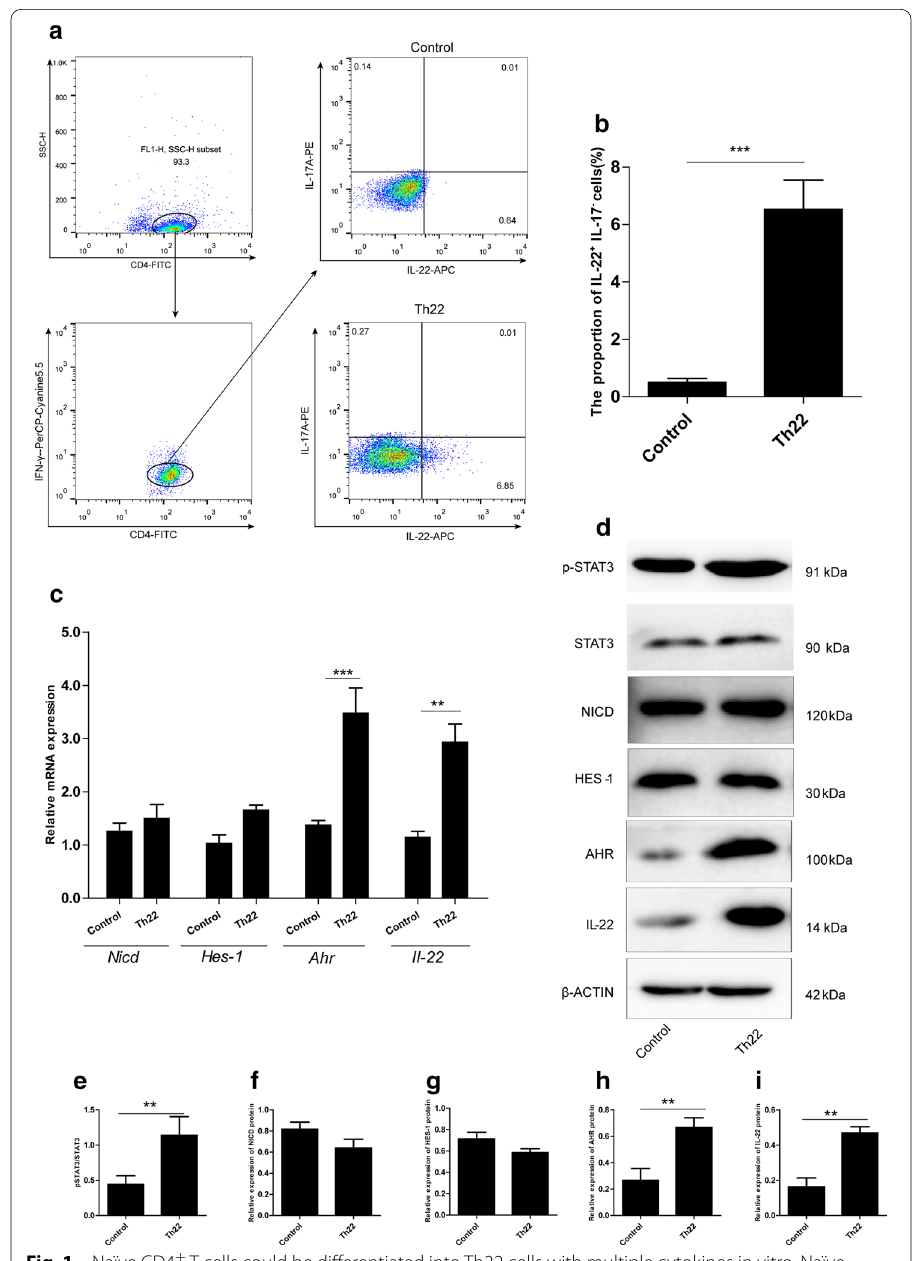
Fig. 1 Naïve CD4 + T cells could be differentiated into Th22 cells with multiple cytokines in vitro. Naïve CD4 + T cells were collected from mice and cultured for 6 days in conditions designed to induce Th22 differentiation (anti-CD3/CD28 Abs, anti-IFN-γ Ab, anti-IL-4 Ab, IL-6, TNF-α, and IL-23). a Representative plots of naïve CD4 + T cells stimulated for 6 days under optimal Th22 conditions. CD4 + T cells and Th (CD4 + IFN-γ − ) were gated by flow cytometry to analyze the Th22 cells. b Percentage quantitation of Th22 cells. c The alterations of Nicd , Hes-1 , Ahr , and Il-22 mRNAs were evaluated by RT-PCR. d Western blotting of the expression of p-STAT3, STAT3, NICD, HES-1, AHR, and IL-22 in total protein lysates from different treatment cells. e–i Representative densitometric quantification of p-STAT3, STAT3, NICD, HES-1, AHR, and IL-22 expression in T cells, β-ACTIN was used as an endogenous control for protein expression. The results show a typical experiment; each bar represents the mean S.E.M. of at least three independent experiments. ± ** p < 0.01, *** p < 0.001, compared with control